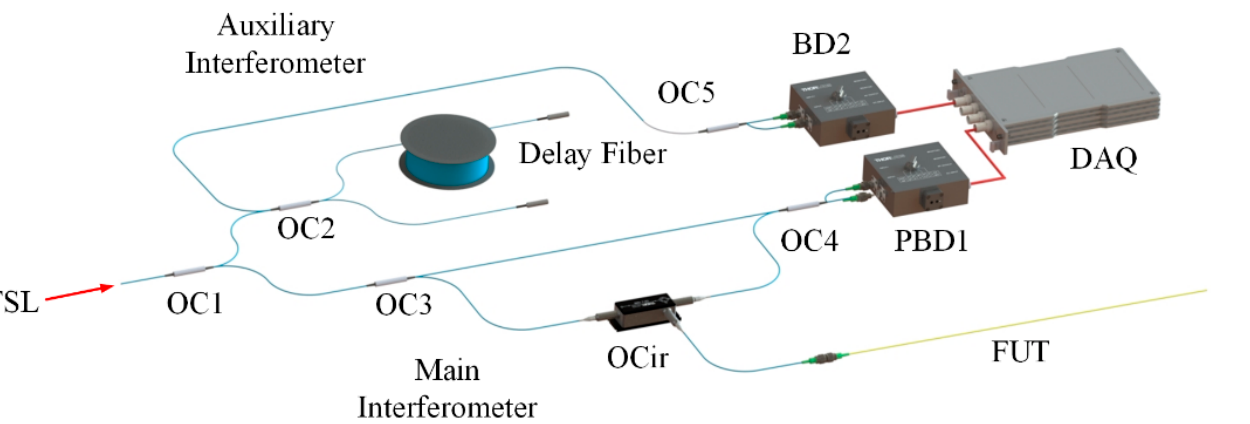
Figure 5. Results of traditional and generalized cross-correlation operations: ( a ) results of the gen- eralized cross-correlation operation based on PHAT; ( b ) results of the traditional cross-correlation operation.